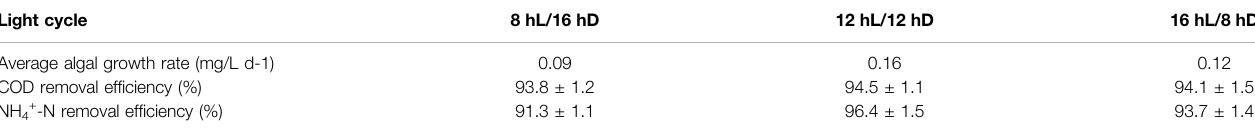
TABLE 2 | Effect of different light cycles (light:dark) on algal growth rate and nutrient removal. Light cycle Average algal growth rate (mg/L